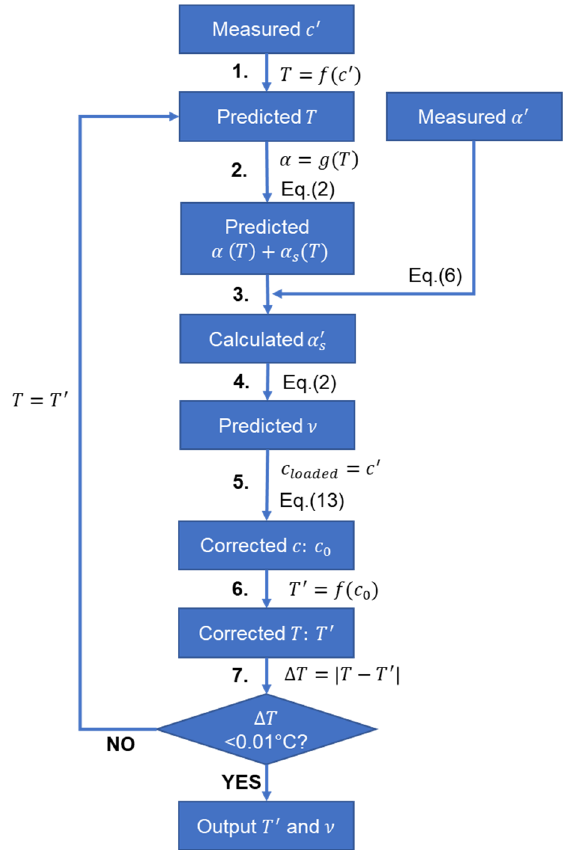
Figure 5. Iteration algorithm for temperature prediction correction based on the measured attenuation due to shear leakage with the effect of the viscous loading by the surrounding fluid.